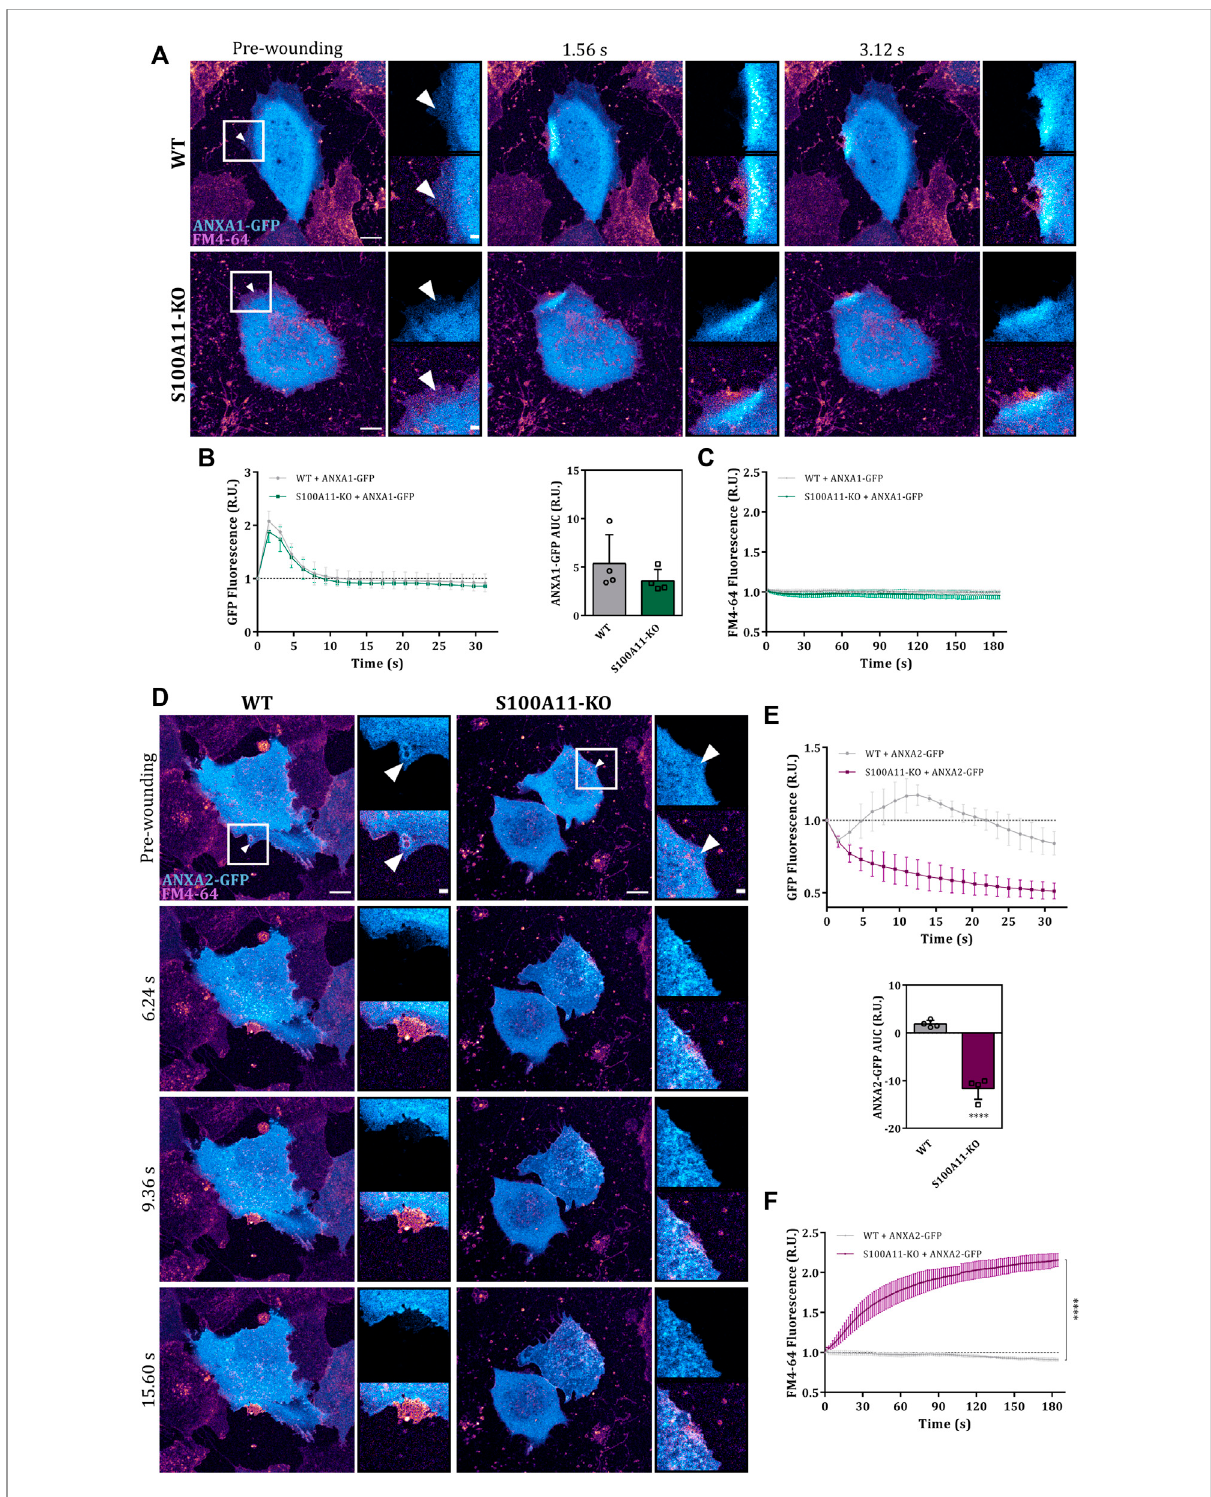
FIGURE 4 AbsenceofS100A11affectsthewoundsiterecruitmentofANXA2butnotANXA1. (A) Time-lapseimagesofANXA1recruitmenttolaser-induced plasma membrane wounds in WT or S100A11-KO cells, respectively (Supplementary Video S6). ANXA1-GFP expressing cells kept in Tyrode ’ s buffer supplemented with 2.5 mM Ca 2+ and 5 μ g/ml FM4-64 were injured at the lateral membrane edge (white triangles represent the wound sites). Wounding occurred at t = 0; pre-wounding and post-wounding time points are shown. Scale bars = 10 µm. Insets highlight the immediate